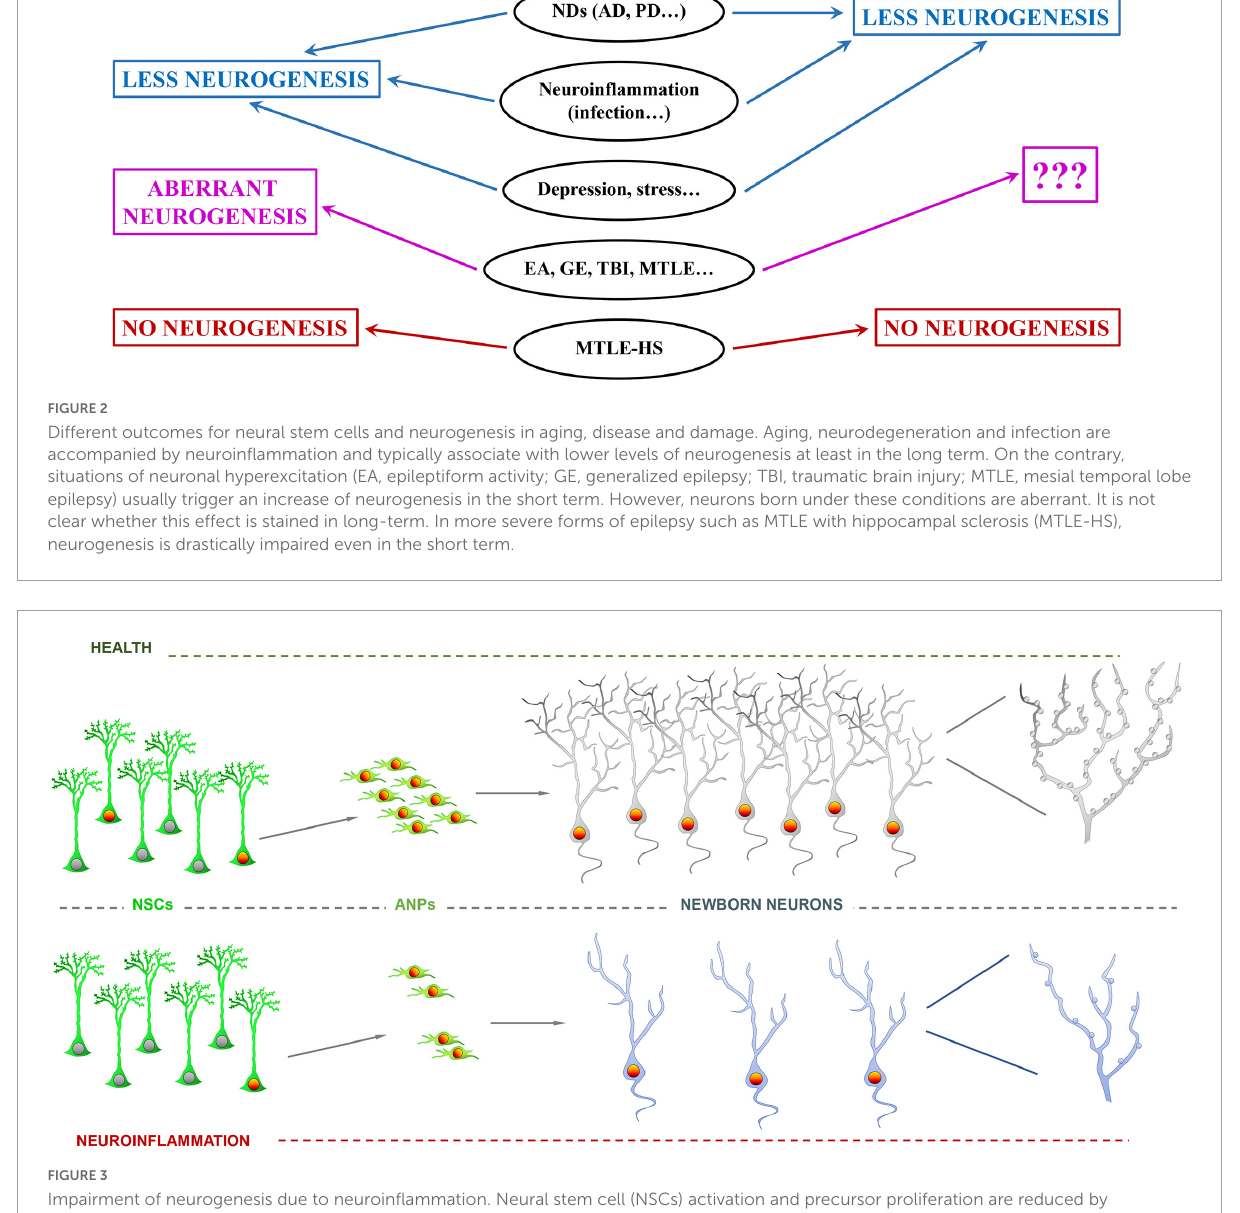
characterized by unilateral neuronal loss in CA, GCL dispersion and intense reactive gliosis and neuroinflammation. In mouse models of MTLE-HS, NSCs get activated massively as they